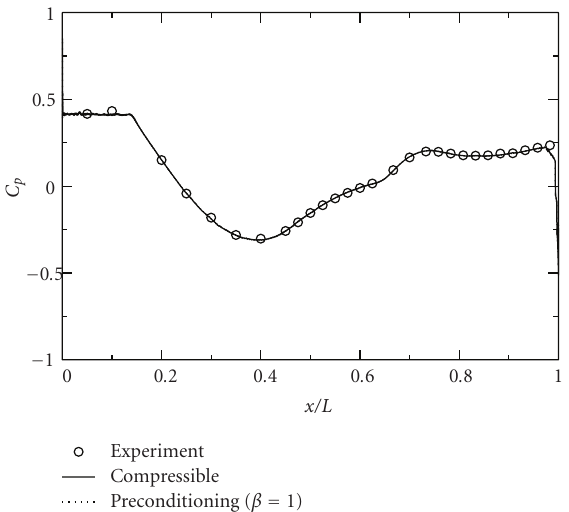
Figure 17: Comparison of predicted and measured C p distribu- tions.